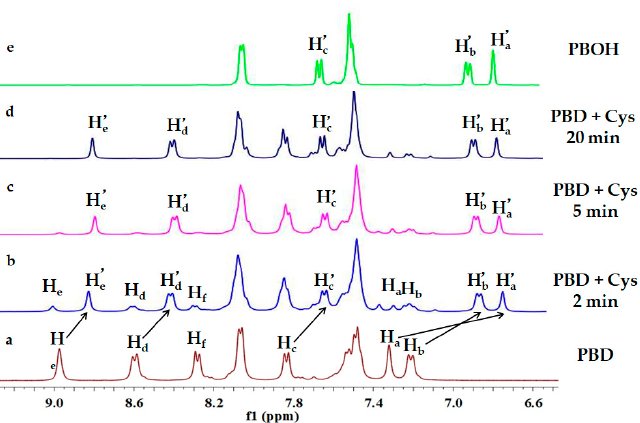
Figure 5. Partial 1 H-NMR spectra of PBD before the addition ( a ) and the change after addition of Cys, 2 min ( b ), 5 min ( c ), and 20 min ( d ), and of PBOH ( e ) in DMSO- d 6 /D 2 O (8/2, v/v ).